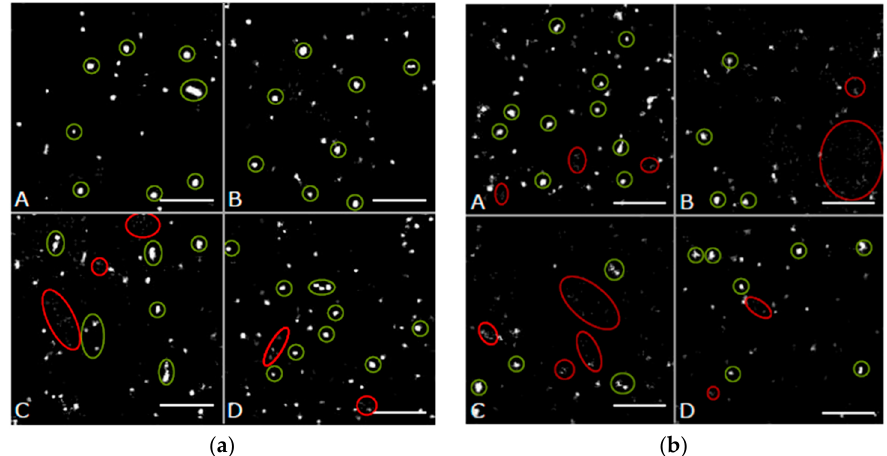
Figure 6. Images of Cx43 molecules in HIMAECs obtained from the coordinate matrices after Single Molecule Localization Microscopy (SMLM). The clustered points (encircled in green) represent points contributing to the peak in Figure 5. The dispersed points (encircled in red) represent points contributing to the right “tail” of the curves in Figure 5. ( a ) peripheral regions, ( b ) perinuclear regions. A = untreated; B = irradiated; C = NRG1 treatment; D = trastuzumab treatment. Scale bar 1 µm.